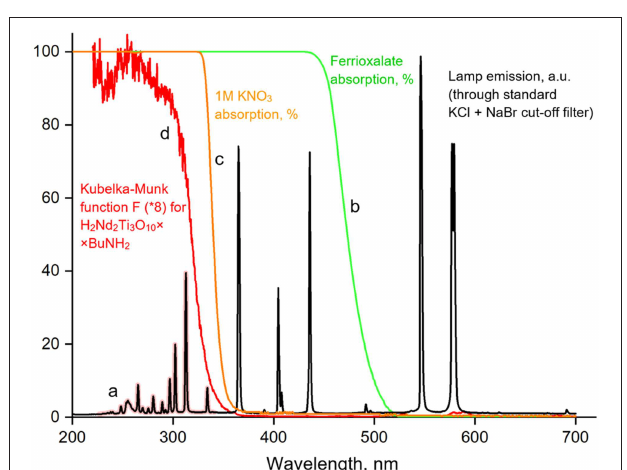
FIGURE 2 | Emission spectrum for the DRT-125 lamp used for photocatalytic experiments (a), absorption of the light-sensitive potassium ferrioxalate solution used for light intensity measurements (b), absorption of the additional KNO 3 cut-off filter (c), absorption of the H 2 Nd 2 Ti 3 O 10 × BuNH 2 photocatalyst expressed by the Kubelka-Munk function (d).